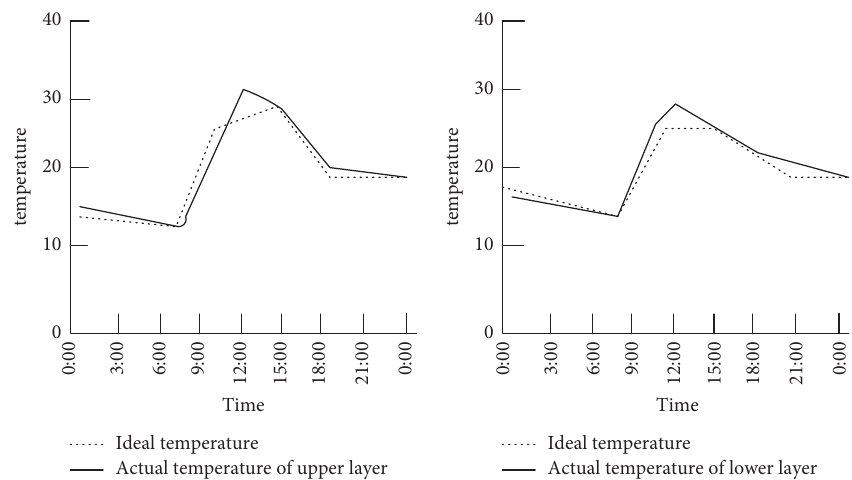
Figure 4: Results of light illumination in the planting of horticultural fruit